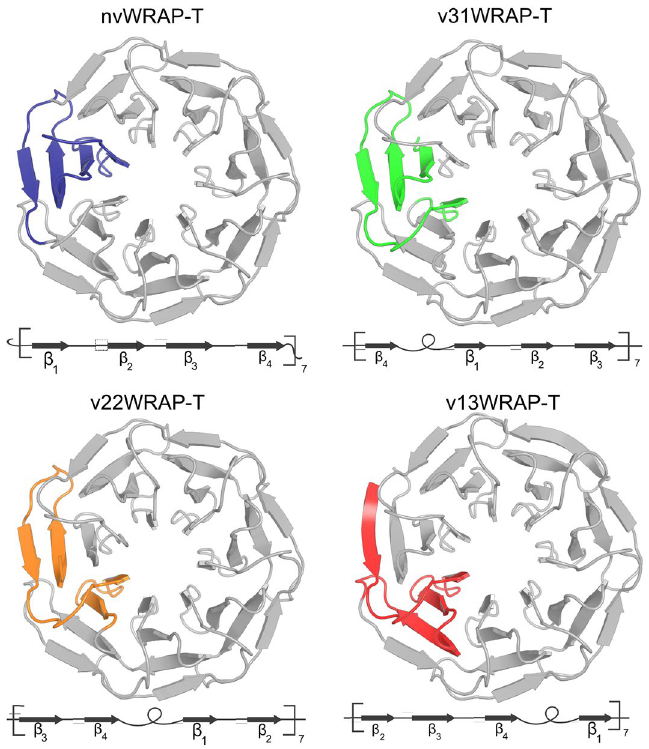
Figure 2. Construction of the “Velcro” variants, each “Velcro” protein has the same sequence but the N-terminal amino acid is shifted within the repeat thus resulting in a different location of the “Velcro”. The first repeat is shown in colour, underneath each structure a diagram is shown illustrating the order of β -strands within the repeat. This figure was created with PyMOL 23